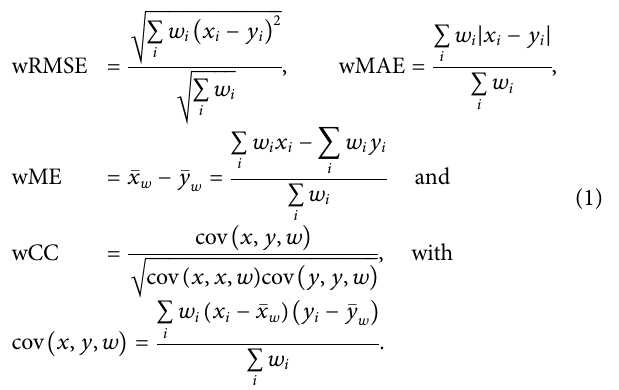
Frontiers in Astronomy and Space Sciences |